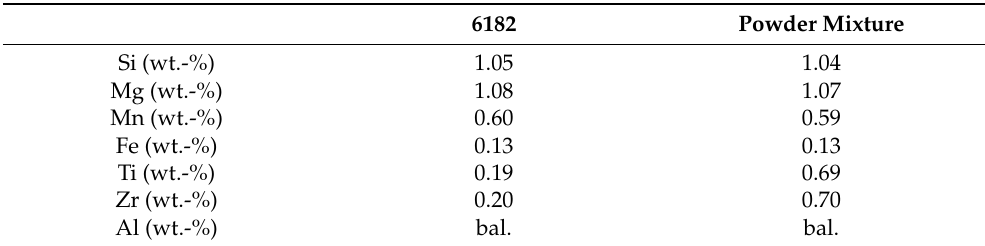
Table 1. Chemical composition of the 6182 pre-alloyed powder and the powder mixture with additional Ti- and Zr-powder.